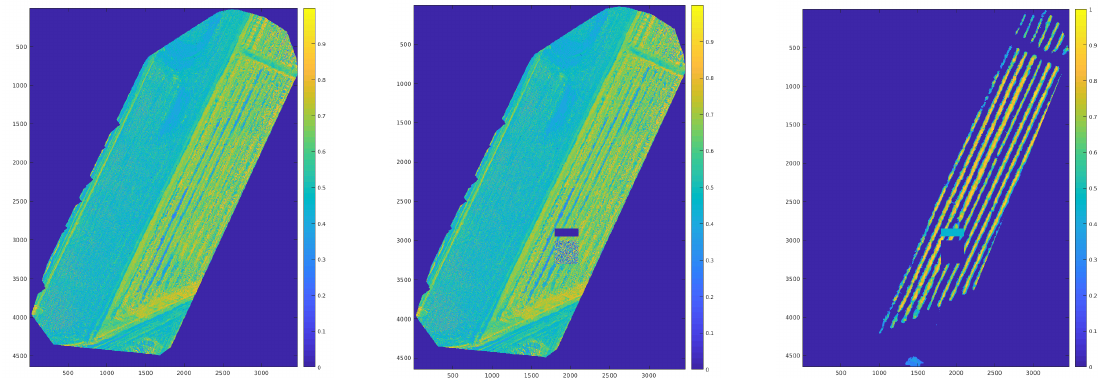
Figure 14. ( left ) The normalized difference vegetation index (NDVI) radiometric index for the ( bottom left ) DSM multi-spectral dataset in Figure 4 clearly identifies crop regions as well as non crop regions along the borders. ( centre ) The NDVI radiometric index for the ( bottom left ) DSM multi-spectral dataset in Figure 4 with a building artifact introduced into the crop field. ( right ) The DSM τ ( x , z ) object field for the ( bottom right ) DSM multi-spectral dataset in Figure 4 with the same building artifact introduced into the crop